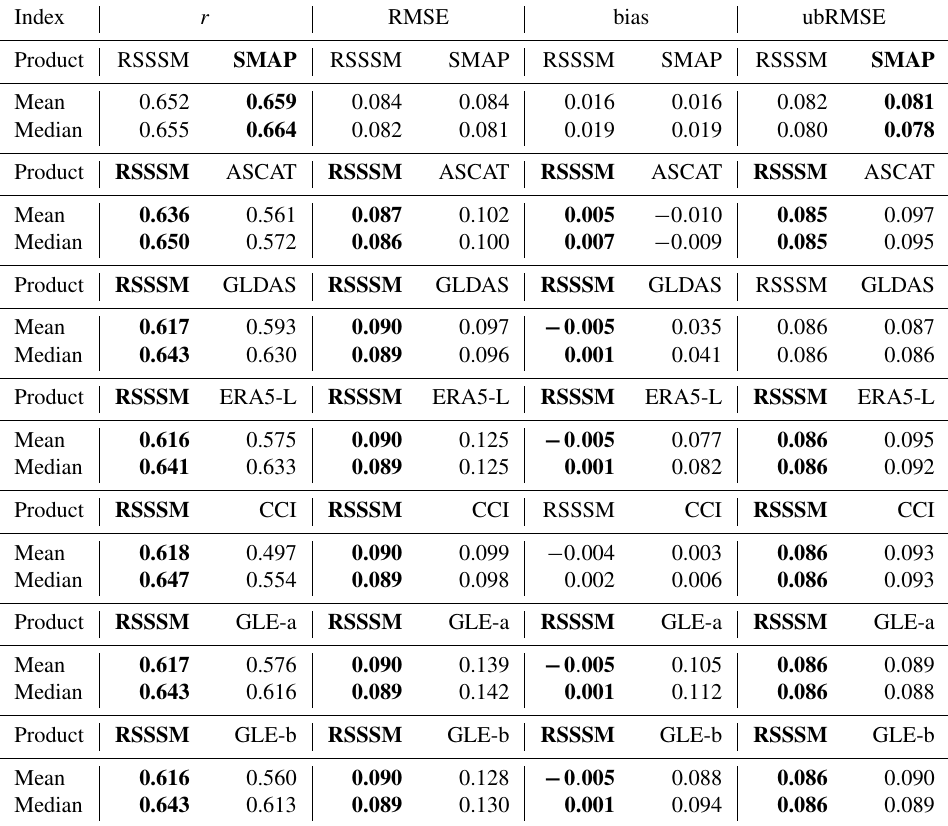
Table 4. Mean and median values of the four evaluation indexes ( r , RMSE, bias, and ubRMSE) on the spatial-pattern accuracy of RSSSM and the other global long-term surface soil moisture products (SMAP_E, ASCAT-SWI, GLDAS Noah v2.1, ERA5-Land, CCI, GLEAM v3.3a, and GLEAM v3.3b) in every 10d period. For each pair of comparisons, the evaluation indexes are for the common period of the two products, and the product with better performance is highlighted in bold (the same as Table 3). The abbreviations for the products are also the same as those in Table